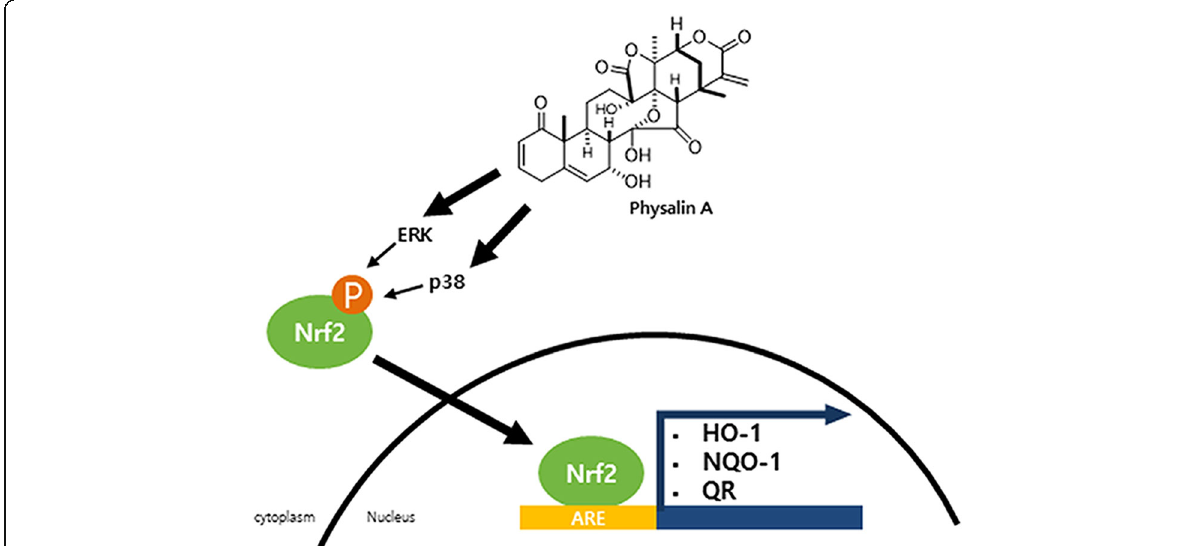
Fig. 7 The hypothetical Nrf2 pathway model induced by physalin A. Physalin A induces the Nrf2 activation and nuclear translocation through Erk or p38 kinase phosphorylation. In the nucleus, ARE binding of Nrf2 induces detoxification gene expression such as NQO-1, HO-1, and